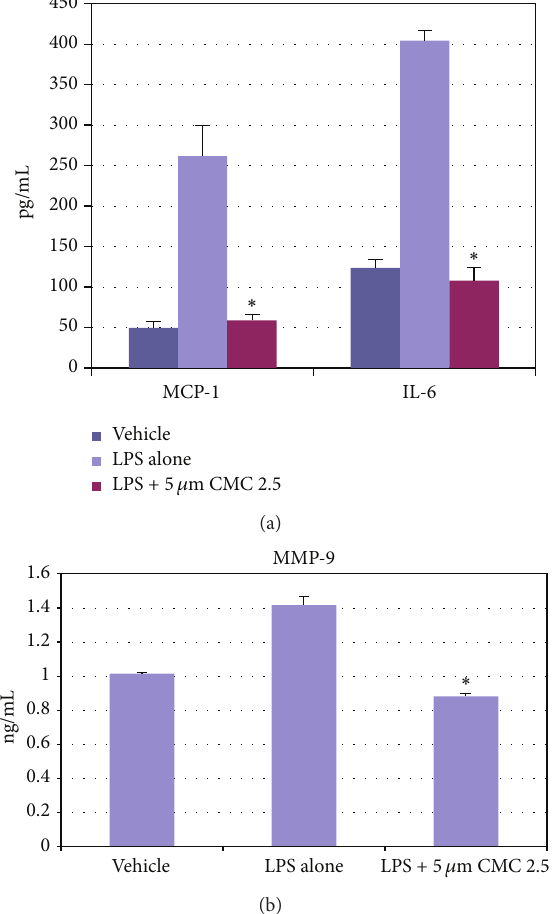
Figure 4: Inhibition of MCP-1, IL-6, and MMP-9 levels by CMC 2.5 in PBMC cells. PBMC cells (5 × 10 5 cells/well) were cultured in serum-free media (37 ∘ C, 95% air, 5% CO 2 ) for 18 hours with LPS ( P. gingivalis , 50ng/mL) or vehicle alone. CMC 2.5 was added at a final concentration of 5 𝜇 M. Conditioned medium was analysed for MCP-1 or IL-6 or MMP-9 by ELISA. Each value represents the mean of 3 cultures ± S.E.M. ∗ 𝑃 < 0.05